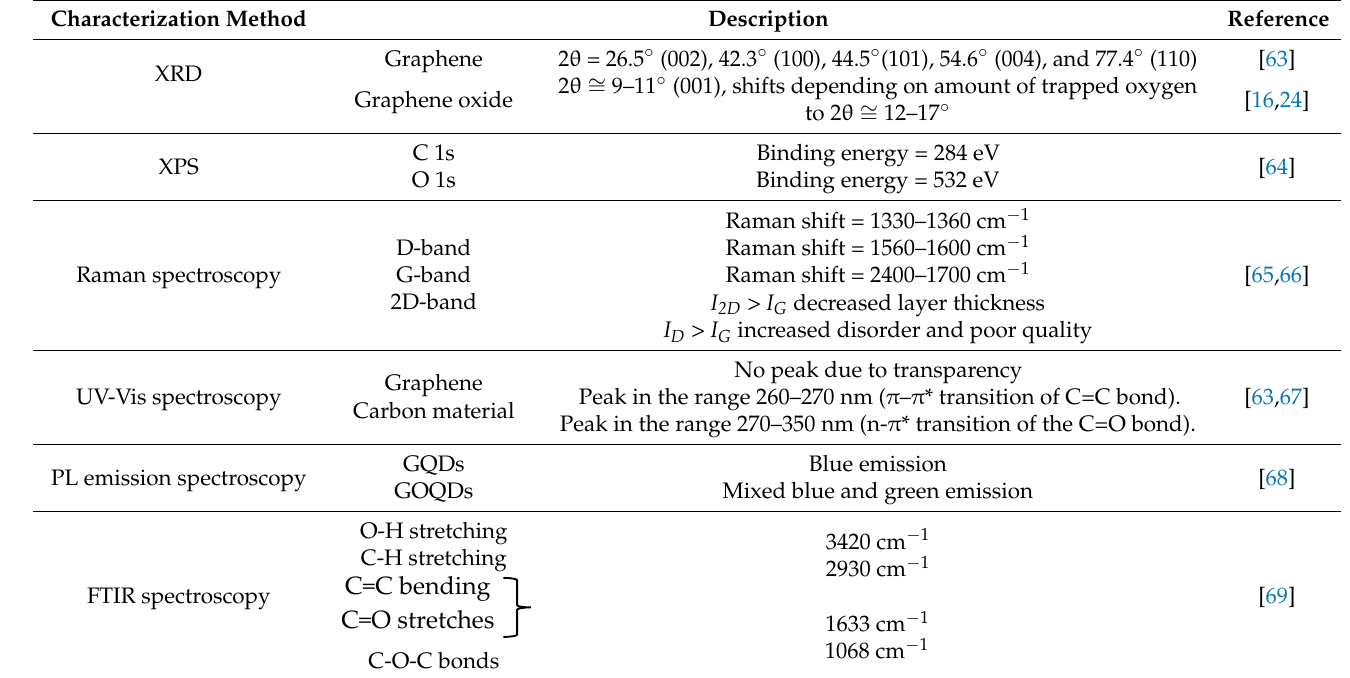
Table 1. Graphene nanostructures analysis techniques and its main features.